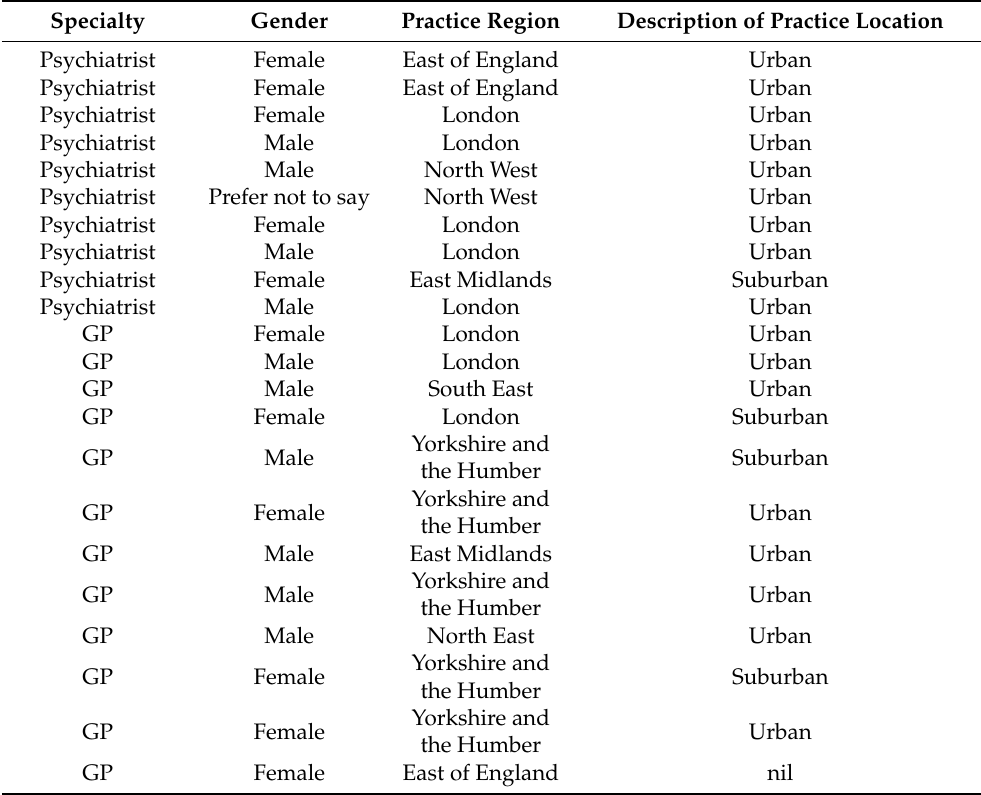
Table 2. Professional characteristics of psychiatrists and GPs